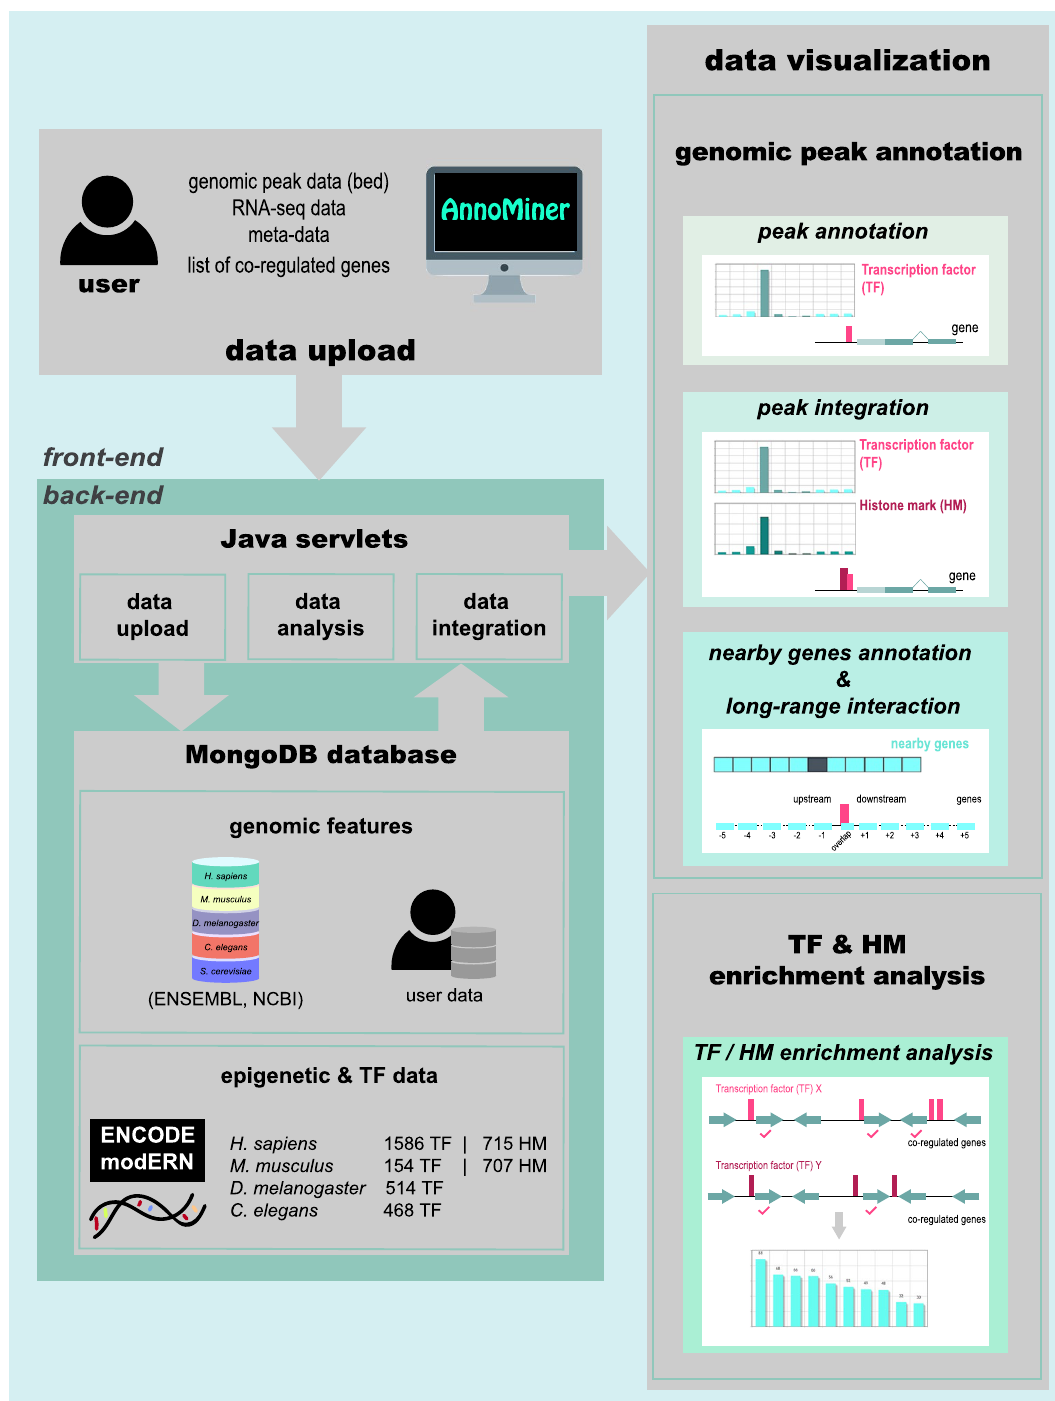
Figure 1. Setup of the AnnoMiner web-server. The user interacts with the web-server via the front-end for data upload and data mining. Genomic peak data (in BED format), annotation data, e.g. from transcriptomic analysis, or a list of co-regulated genes can be uploaded to the server. The user can either annotate peaks ( peak annotation ), integrate peaks ( peak integration ) or annotate and analyse nearby genes ( nearby genes annotation, long-range interactions ) of a peak. AnnoMiner’s fourth function allows searching for enriched transcription factor binding or histone modification events in the promoter regions of a list of co-regulated genes ( TF & HM enrichment analysis ). In the back-end, Java servlets are responsible for data upload, analysis, integration and ID conversion. User data, genome feature data from ENSEMBL, UCSC and NCBI, as well as ENCODE, modENCODE and modERN ChIP-seq data are stored in a MongoDB database. Currently, we host genome feature data from H. sapiens , M. musculus , D. melanogaster , C. elegans and S. cerevisiae . Data from ENCODE, modENCODE and modERN are available in AnnoMiner for human, mouse, Drosopihla and C. elegans